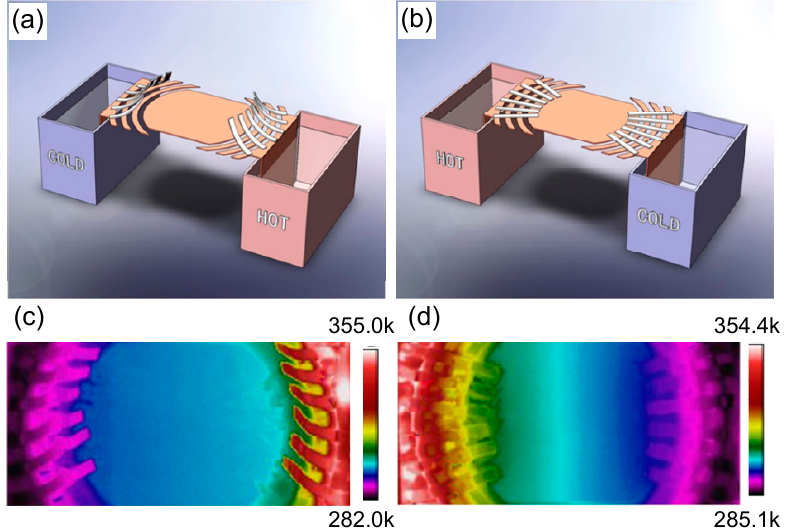
Figure 6. Experimental demonstration of the macroscopic thermal diode [21]. ( a , b ) Schematic diagrams of the macroscopic thermal diode in insulation state and conduction state, respectively; ( c , d ) measured temperature distributions of ( a , b ), respectively.